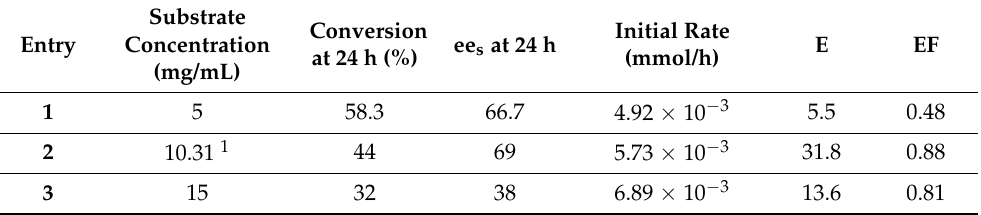
Table 4. Effect of the substrate concentration on the kinetic resolution of rac -ibuprofen in isooc- tane/DCM.